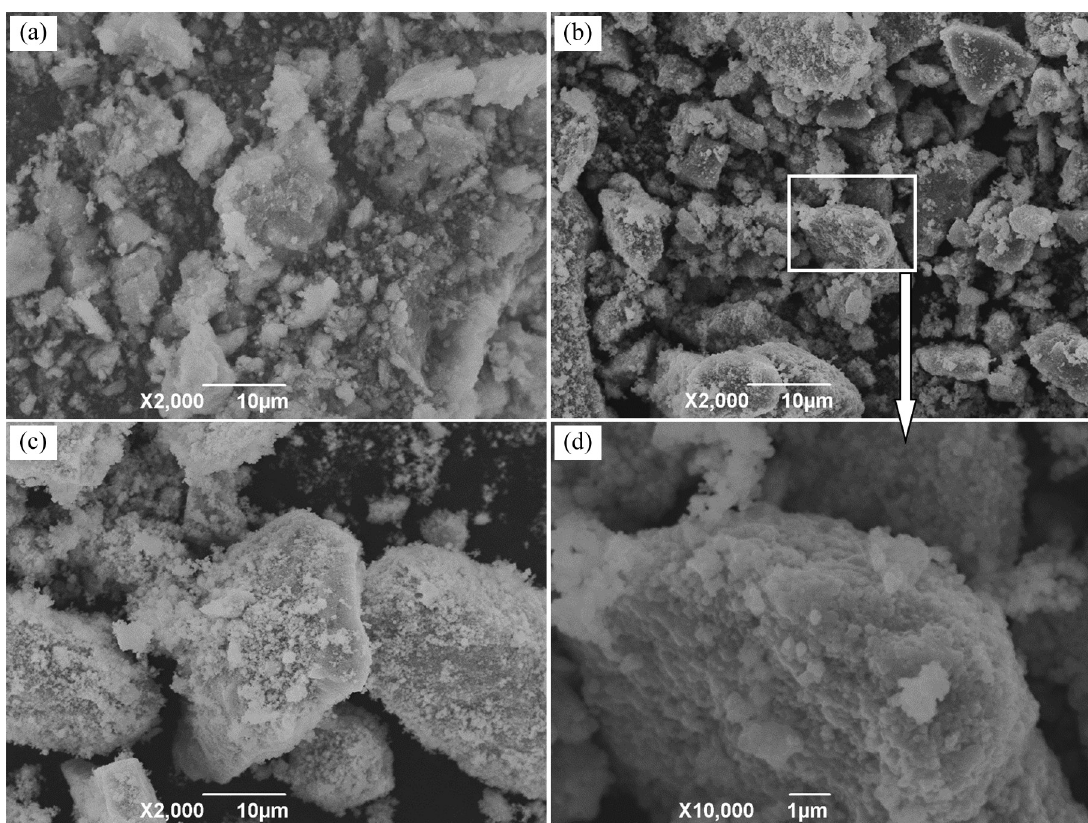
Figure 2. The typical SEM micrographs of specimens NZ-P (a), NZ-700 (b) and NZ-900 (c). (d): the detailed micrograph marked in